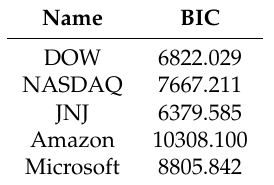
Table 12. The BIC of the Best Model of One-period Gambles for the Stock